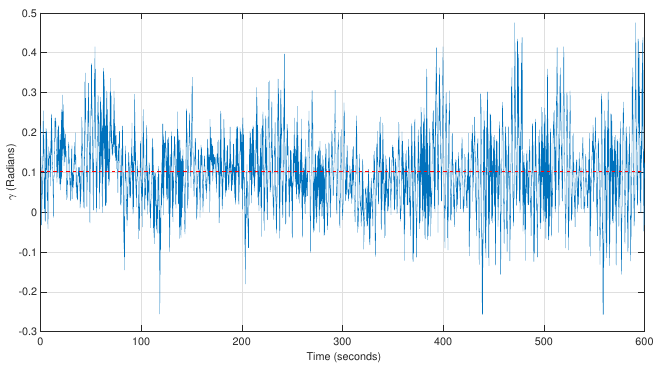
Figure 11. Deviation γ for above-rated wind speed (22 m/s).